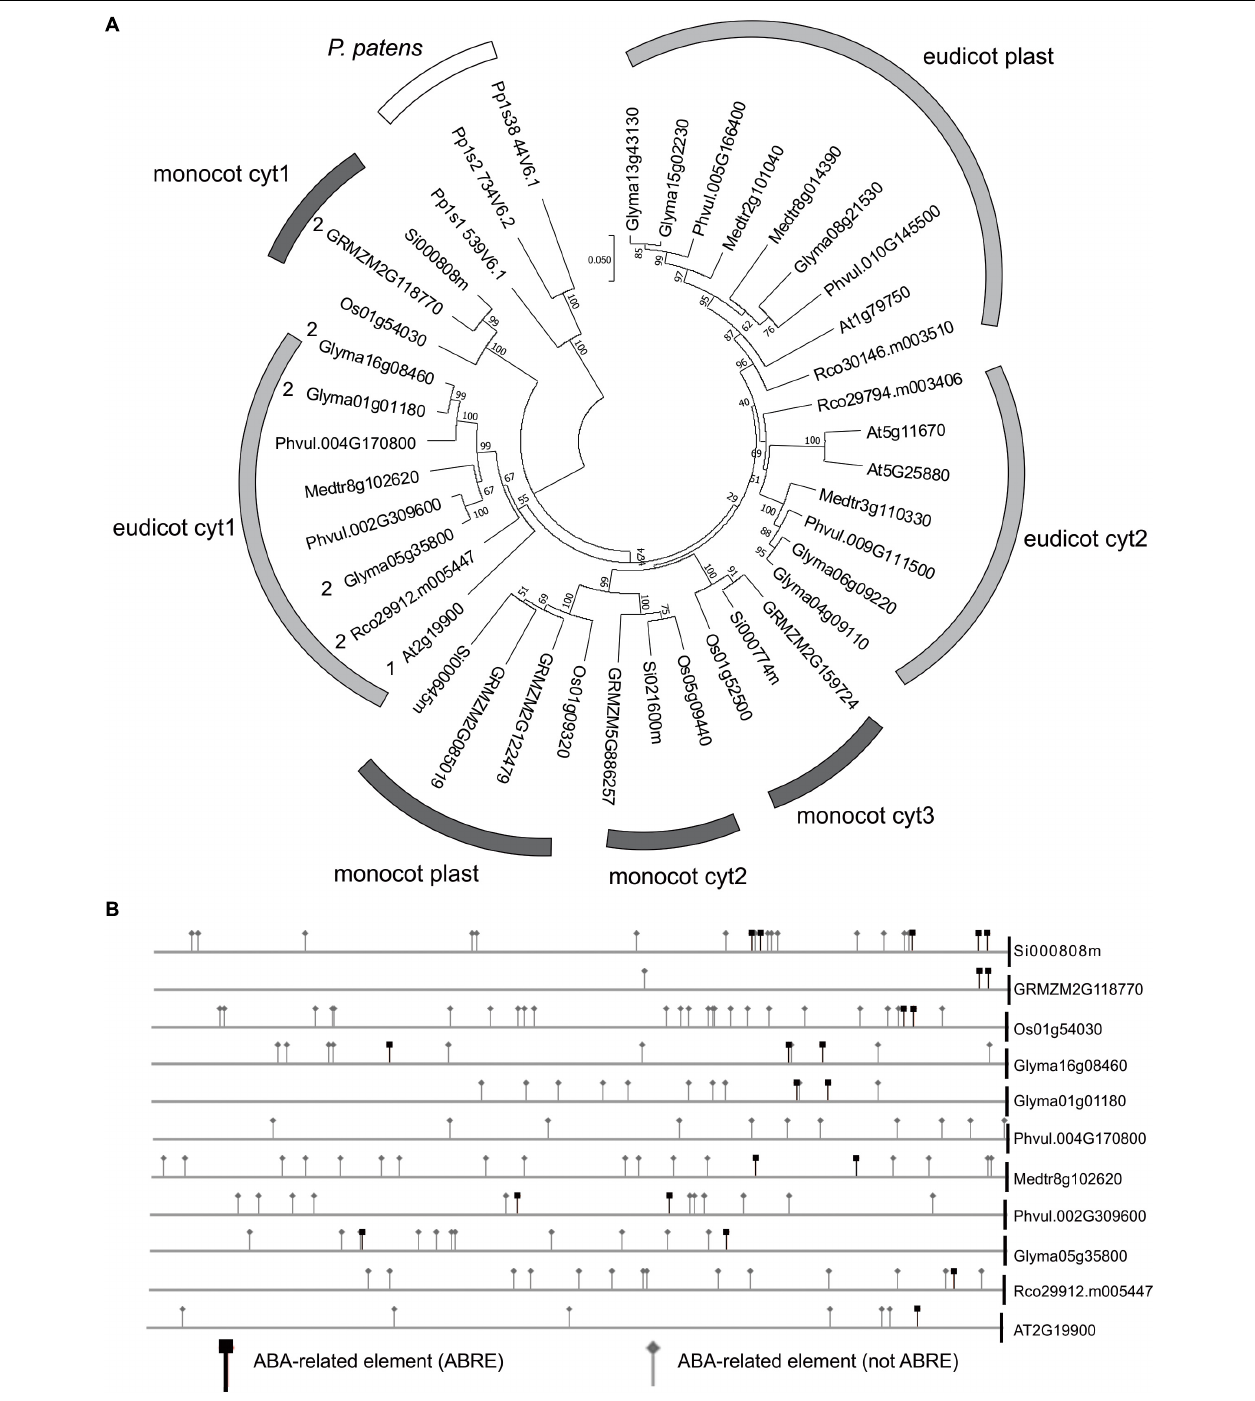
FIGURE 5 | ABA and drought response elements in the promoters of NADP-ME1 and related genes. (A) The evolutionary history of the complete set of NADP-ME isoforms from the dicot species Arabidopsis (At), soybean (Glyma), Medicago truncatula (Medtr), Phaseolus vulgaris (Phvul), Ricinus communis (Rco) and the monocot species rice (Os), Setaria italica (Si), and maize (GRMZM) was inferred using the Neighbor-Joining method. The optimal tree with the sum of branch length = 2.44632768 is shown. The tree is drawn to scale, with branch lengths in the same units as those of the evolutionary distances used to infer the phylogenetic tree. The evolutionary distances are in the units of the number of amino acid substitutions per site. (B) The occurrence of ABA responsive elements was analyzed in the promoters of monocot cyt1 and dicot cyt1 groups.